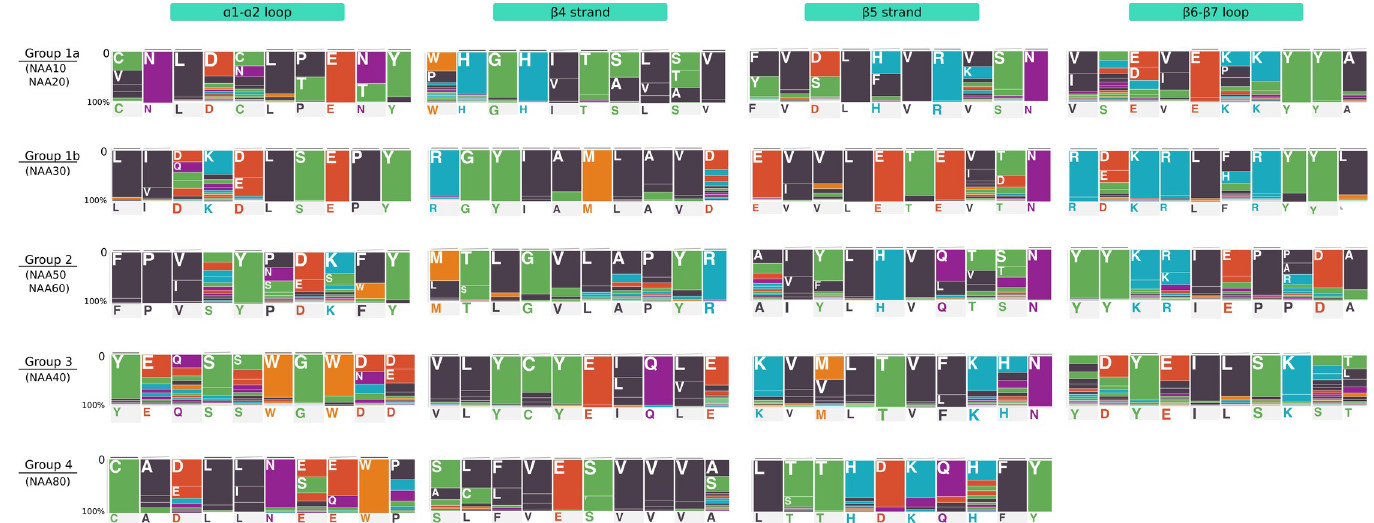
Fig 3. Characteristic sequence motif fingerprints of NAT Groups 1 to 4. Sequence motifs were calculated as described in the Material and Methods section and using sequences from the SSN clusters. Each position in the motif is represented by a colored bar and a one-letter code for the amino acid frequently found at that position in the GNAT fold. The height of colored bar is proportional to the frequency of the corresponding amino acid. The colors correspond to the type of amino acid (blue: R, H, K; red: D, E; green: C, S, G, Y, T; black: P, F, V, L, I, A; orange: M, W; purple: N, Q). Group 5 is not shown as there is no structure of NAA70 available.